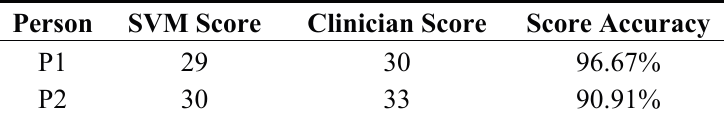
Table 5. A comparison of the FMA scores assigned by our implemented system and the score assigned by the